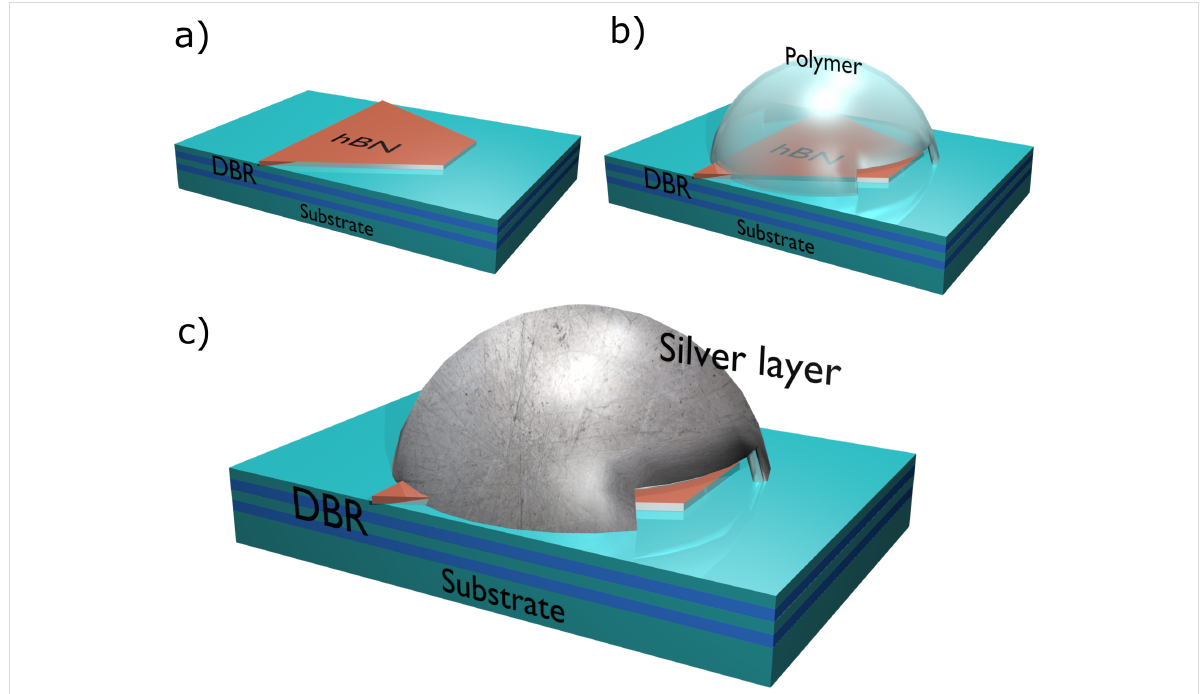
Figure 2: Fabrication steps of hybrid microcavity. (a) hBN layer positioned on top of DBR. (b) Concave polymer shape is fabricated by direct laser writing process. (c) A silver layer is added on top of polymer.